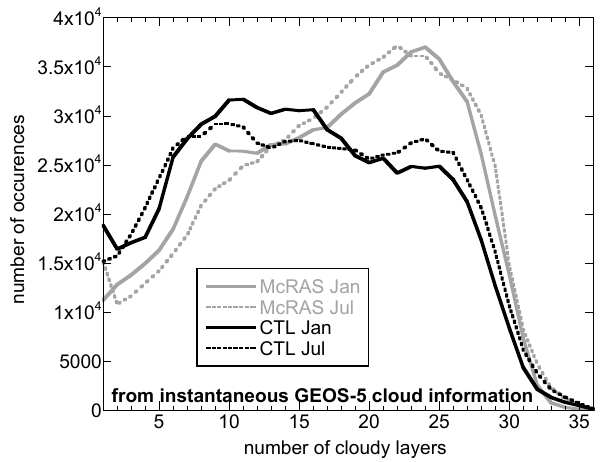
Fig. 12. Frequency distributions of instantaneous multi-layer cloud occurences using the same data as in Fig.